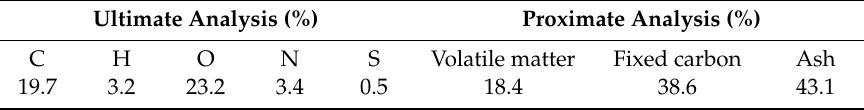
Table 1. Ultimate and proximate analysis of activated sludge.